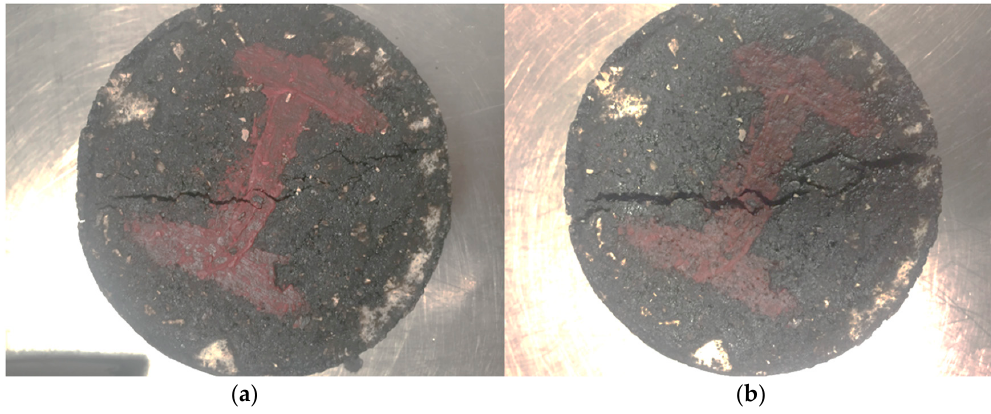
Figure 7. The broken specimen before heating ( a ), and the enlargement of the crack after the heating without rubber bands ( b ).